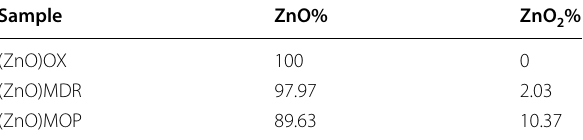
Table 1 X‑ray diffraction analysis of the zinc oxide (ZnO) nanoparticle (NP) samples prepared using three methods (ZnO) OX, (ZnO)MDR, and (ZnO)MOP) showing the variation in ZnO NP content according to the preparation method used